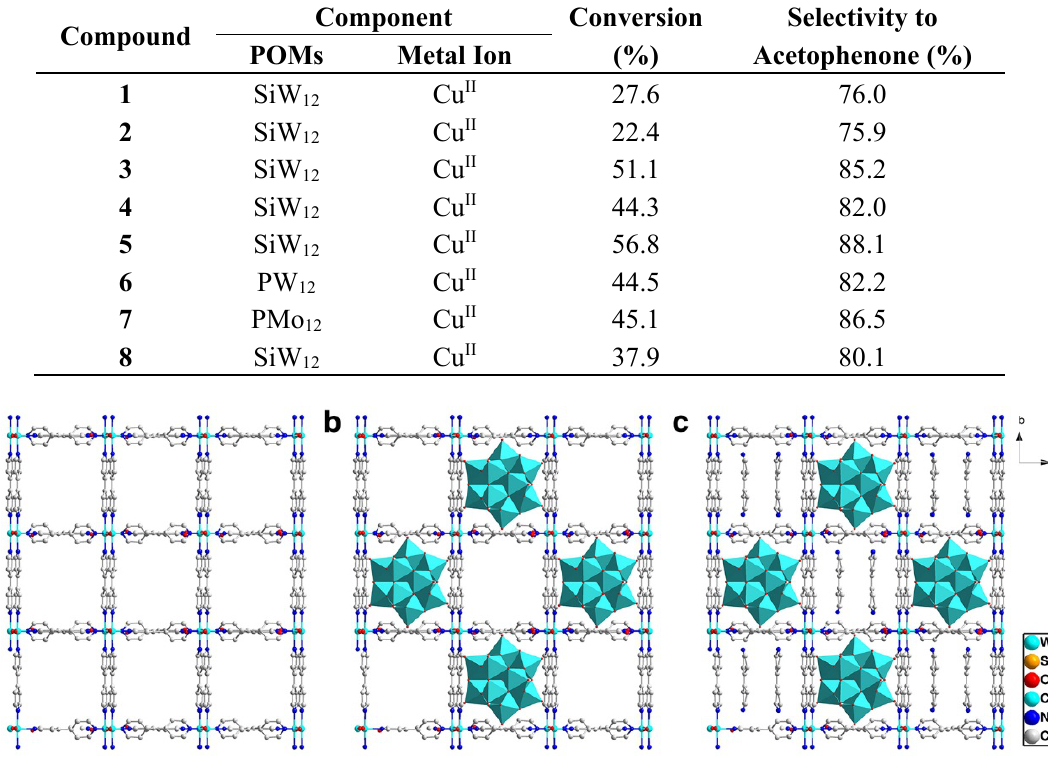
Figure 7. ( a ) The 2D layer of [Cu(4,4'-bpy) 2 (H 2 O) 2 ] n 2 n + in compounds 5 – 8 ; ( b ) Polyhedral and ball-and-stick representation for compounds 5 – 7 ; ( c ) Polyhedral and ball-and-stick representation for compound 8